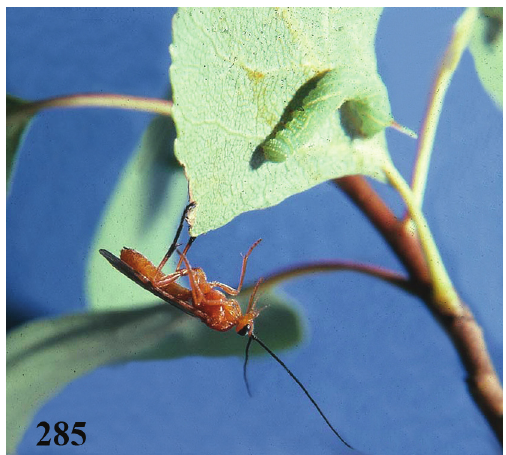
Figure 285. Aleiodes praetor (Reinhard), ♀ , hanging from a leaf edge.